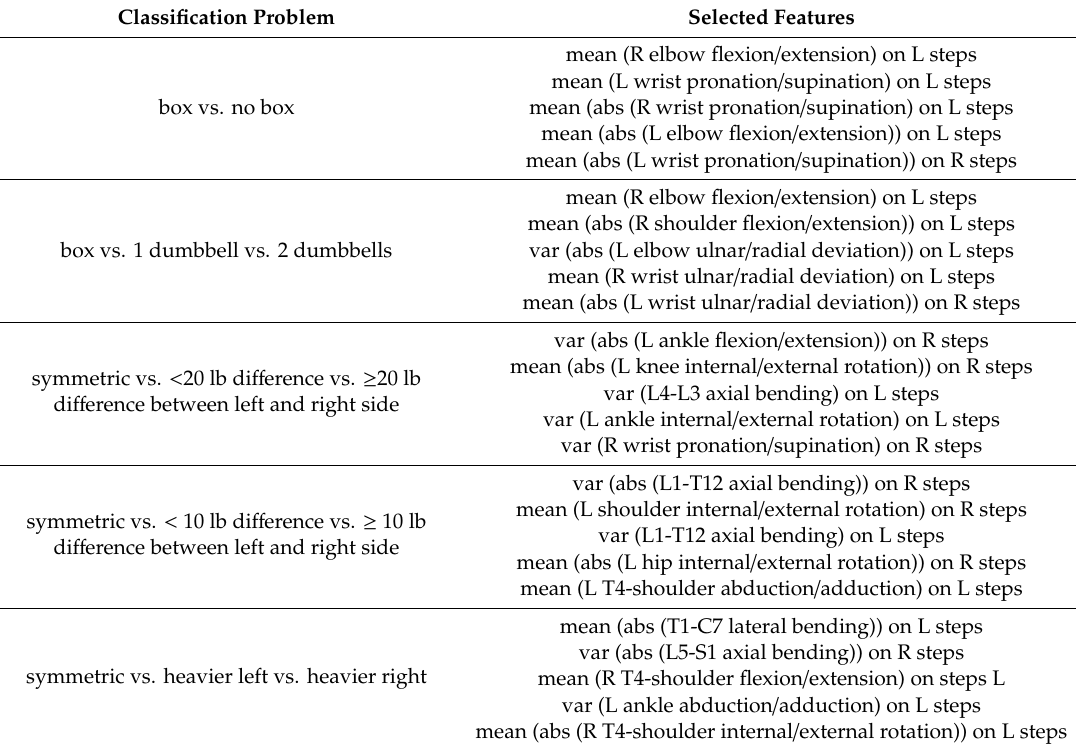
Table 2. Top 5 selected features for each classification problem. R—right; L—left; var—variance, abs—absolute